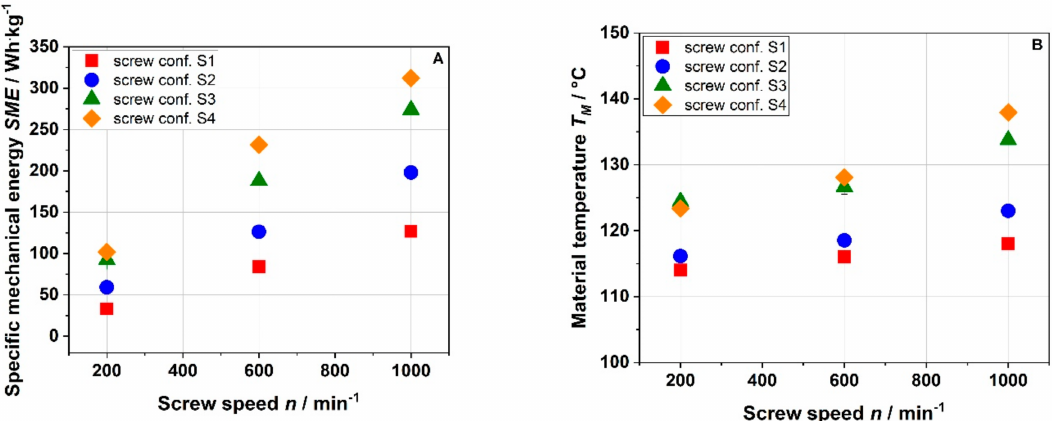
Figure 2. Specific mechanical energy input (SME) ( A ) and material temperature (T M ) ( B ) for conventional apple pomace treated at various screw speed and screw configurations (S1: only transport elements, S2: two reverse elements, S3: four reverse elements, S4: two reverse elements and a kneading block) at 22% water content and a barrel temperature T B of 120 ◦